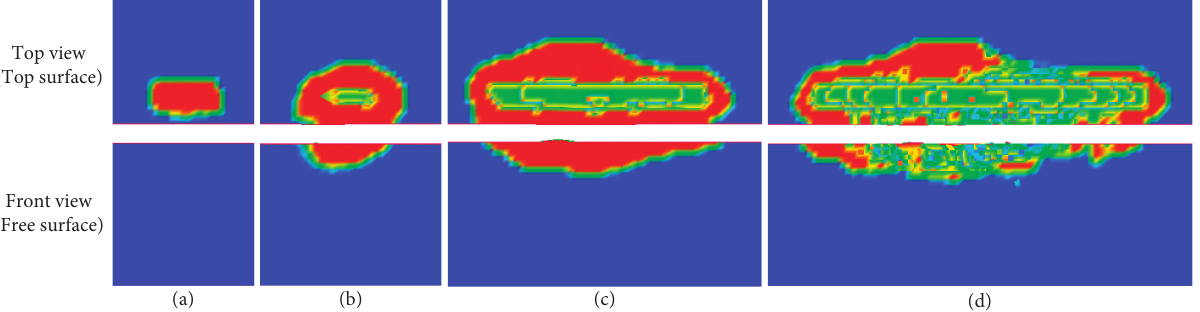
Figure 4: Rock damage nephogram of sawblade cutting into rock vertically.